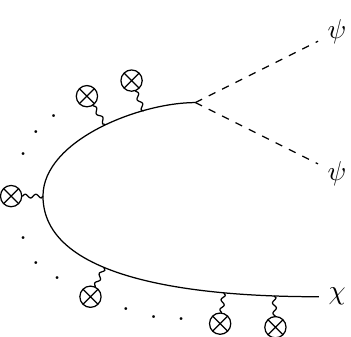
Figure 1 . A diagrammatic picture of instant preheating. A pair of χ particles (solid line) are produced from the vacuum, one of which subsequently decays into a pair of ψ particles (dashed lines). The parent χ particles couple to the coherent φ field (blobs) in a non-perturbative manner, while the daughter ψ particles do